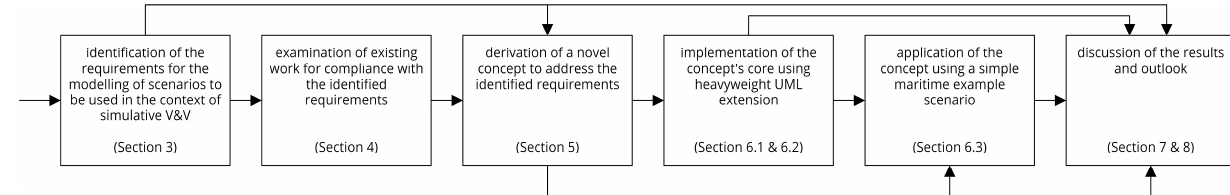
Figure 3. The structure of the present work depicted as a flow chart. The boxes represent the elementary steps and refer to the respective sections. The arrows represent the flow of (partial) results and findings between them. For example, the identified requirements are used both for the examination of related work, for the development of the novel concept, and for the final discussion of the